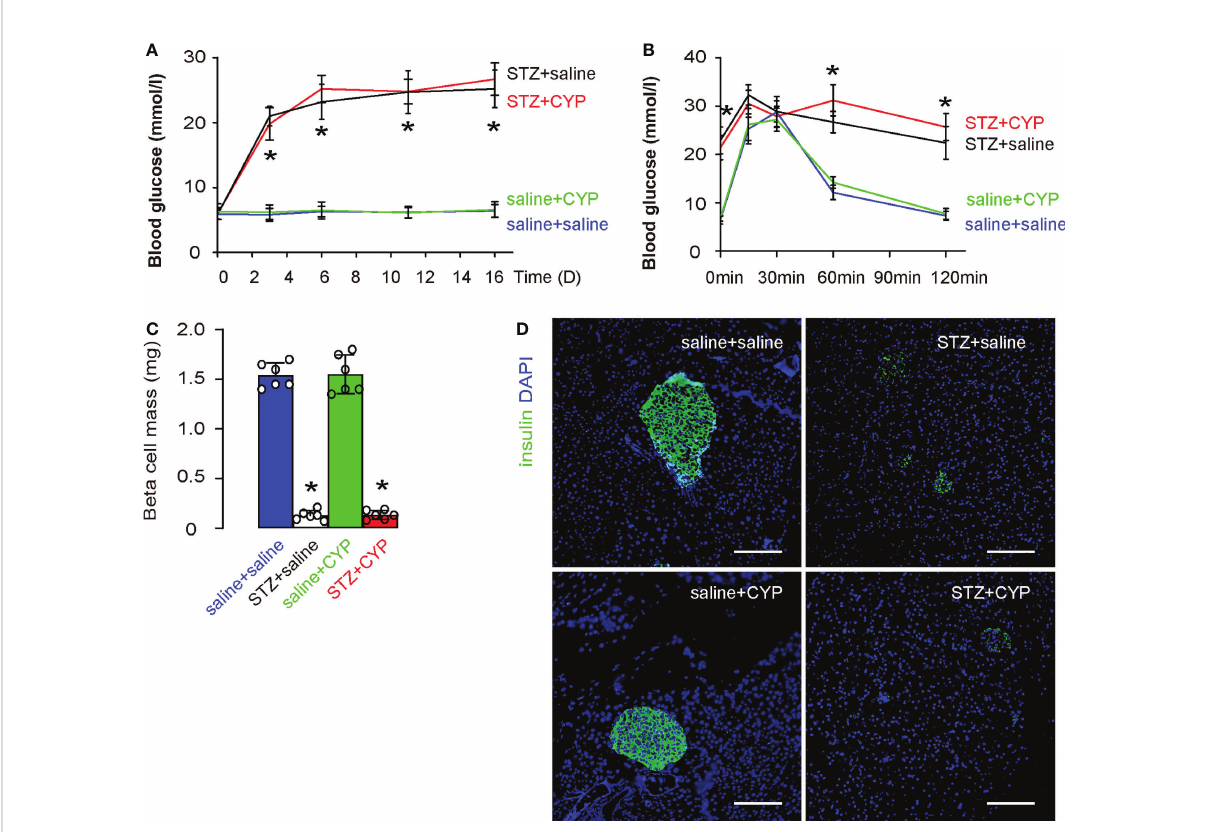
FIGURE 2 CYP-induced cystitis does not affect diabetic status in mice. (A) Fasting blood glucose. (B) IPGTT at D16. (C) Beta cell mass at D16. (D) Representative insulin staining in mouse pancreas. *p<0.05 (STZ+CYP vs saline+CYP or STZ+saline vs saline+saline). Scale bars are